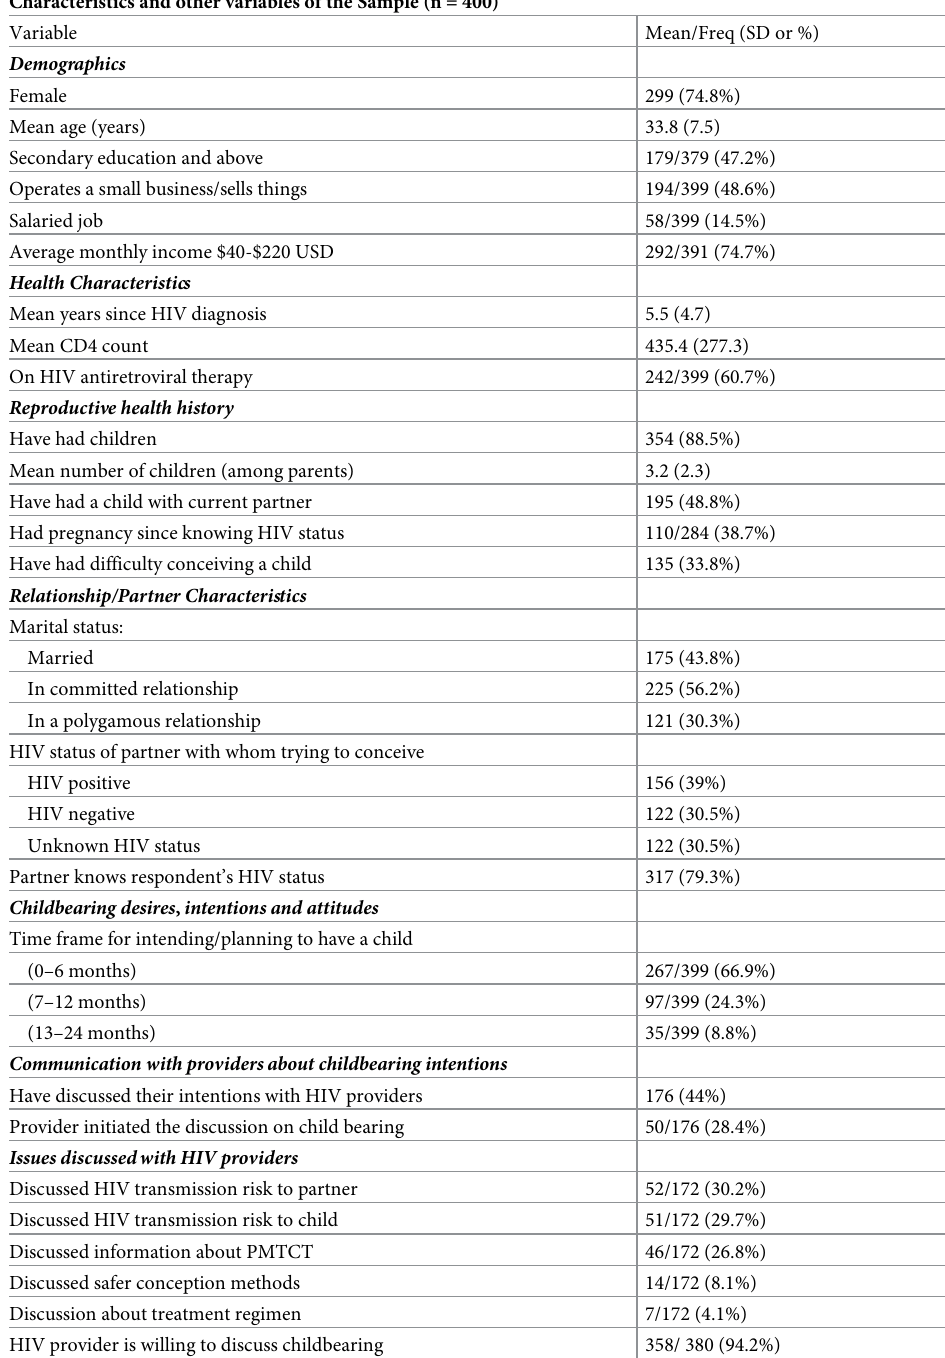
Table 1. Characteristics of people living with HIV desiring to have children. Characteristics and other variables of the Sample (n = 400) Variable Mean/Freq (SD or %) Demographics Female 299 (74.8%) Mean age (years) 33.8 (7.5) Secondary education and above 179/379 (47.2%) Operates a small business/sells things 194/399 (48.6%) Salaried job 58/399 (14.5%) Average monthly income $40-$220 USD 292/391 (74.7%) Health Characteristics Mean years since HIV